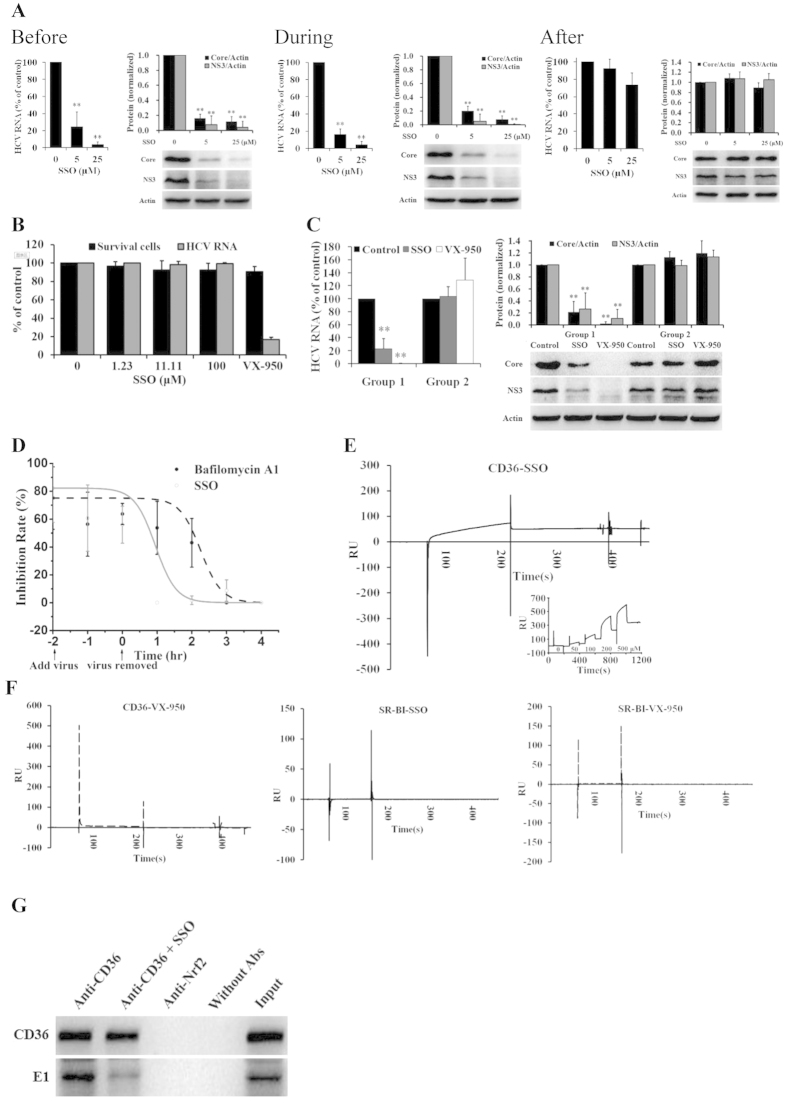
SSO directly bound CD36 and prevented HCV from attachment on host cells.(A) SSO only inhibited HCV replication at early stage of HCV life cycle (n = 3 for RNA, n = 4 for protein). Huh7.5 cells were treated with SSO before (at −2 hr), during (at 0 hr) or after (at 2 hr) HCV infection (150 IU/cell). After 2 hrs incubation, the supernatants were replaced with fresh culture media. Intracellular HCV RNA and proteins were detected in 72 hrs. **P < 0.01, vs solvent control. (B) SSO did not inhibit the replication of HCV sub-genome replicon in GS4.3 cells (n = 3). GS4.3 cells were treated with SSO or solvent control. After 72 hrs incubation, intracellular RNAs were detected, and cytotoxicity was measured with a MTT assay. VX-950 (1.0 μM) served as a positive control in the test. (C) SSO did not show direct inactivation on HCV (left, RNA; right, proteins) (n = 3 for RNA, n = 5 for protein). The experiment protocol is in the Method section. Intracellular HCV RNA and proteins were measured. **P < 0.01, vs solvent control in the same group. (D) Time-of-addition experiment showed that SSO prevents HCV from replication at early stage (n = 3). The experiment protocol is in the Method section. Intracellular HCV RNA was detected with qRT-PCR. Fitted lines represent sigmoidal time-dependent curves. (E) The direct interaction between CD36 and compound SSO was analyzed with BIAcore, and the interaction was in a dose-dependent manner (insert). (F) There was no direct interaction between CD36 and VX-950 (left), or SSO and SR-BI (middle), or VX-950 and SR-BI (right), in the BIAcore analysis. The protein bands presented showed the results of a representative experiment. Presented is mean ± standard deviation, and Student’s t-test was used in (A–D). (G) The interaction between CD36 and HCV E1 protein was disrupted by SSO. Co-IP assay was performed with the lysates of HCV-infected Huh7.5 cells and 20 μM SSO was added additionally. Anti-Nrf2 antibody was used as an irrelevant negative control, and Without Abs as blank control.